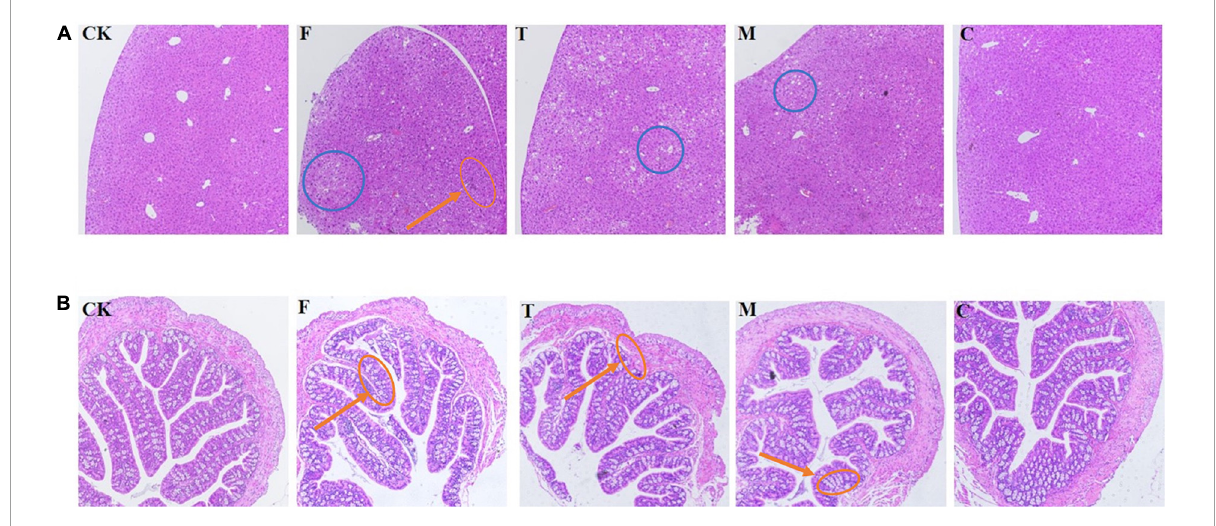
FIGURE2 Histological examination of the liver and colon tissues (H&E, 100 × ). (A) Histological examination of liver tissue. (B) Histological examination of the colon tissue. Red callouts indicated inflammation; blue callouts indicated fat deposits.